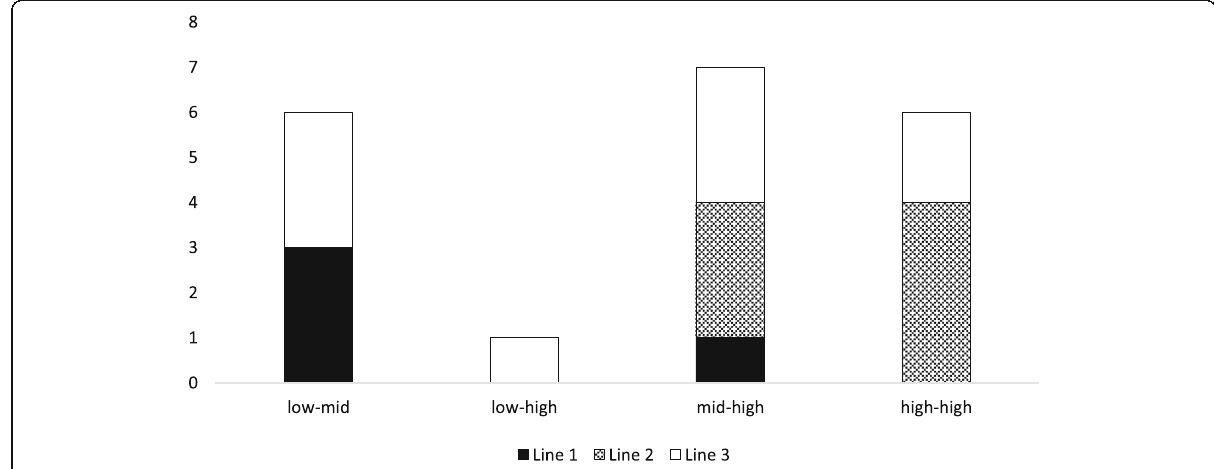
Fig. 4 Distribution of coupling types of rail transit lines 1, 2 and 3